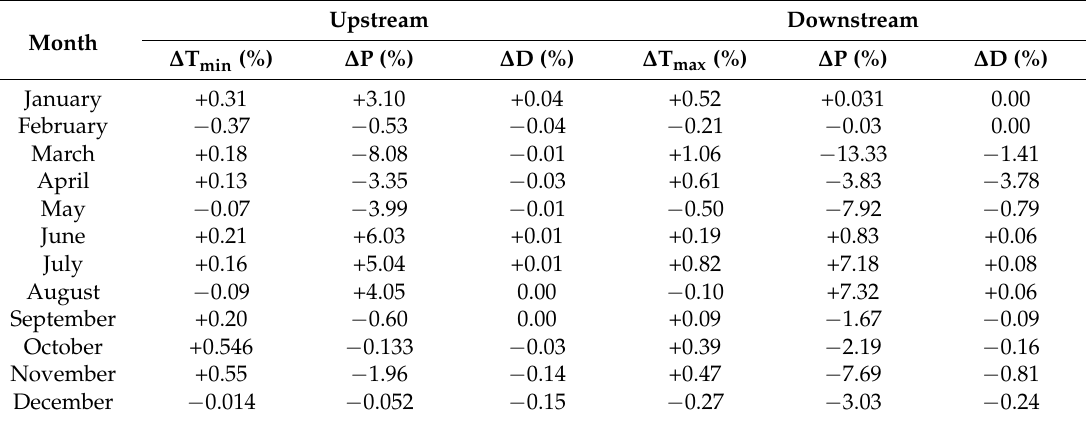
Table 3. Predicted monthly hydro-climatic changes in Muooni catchment